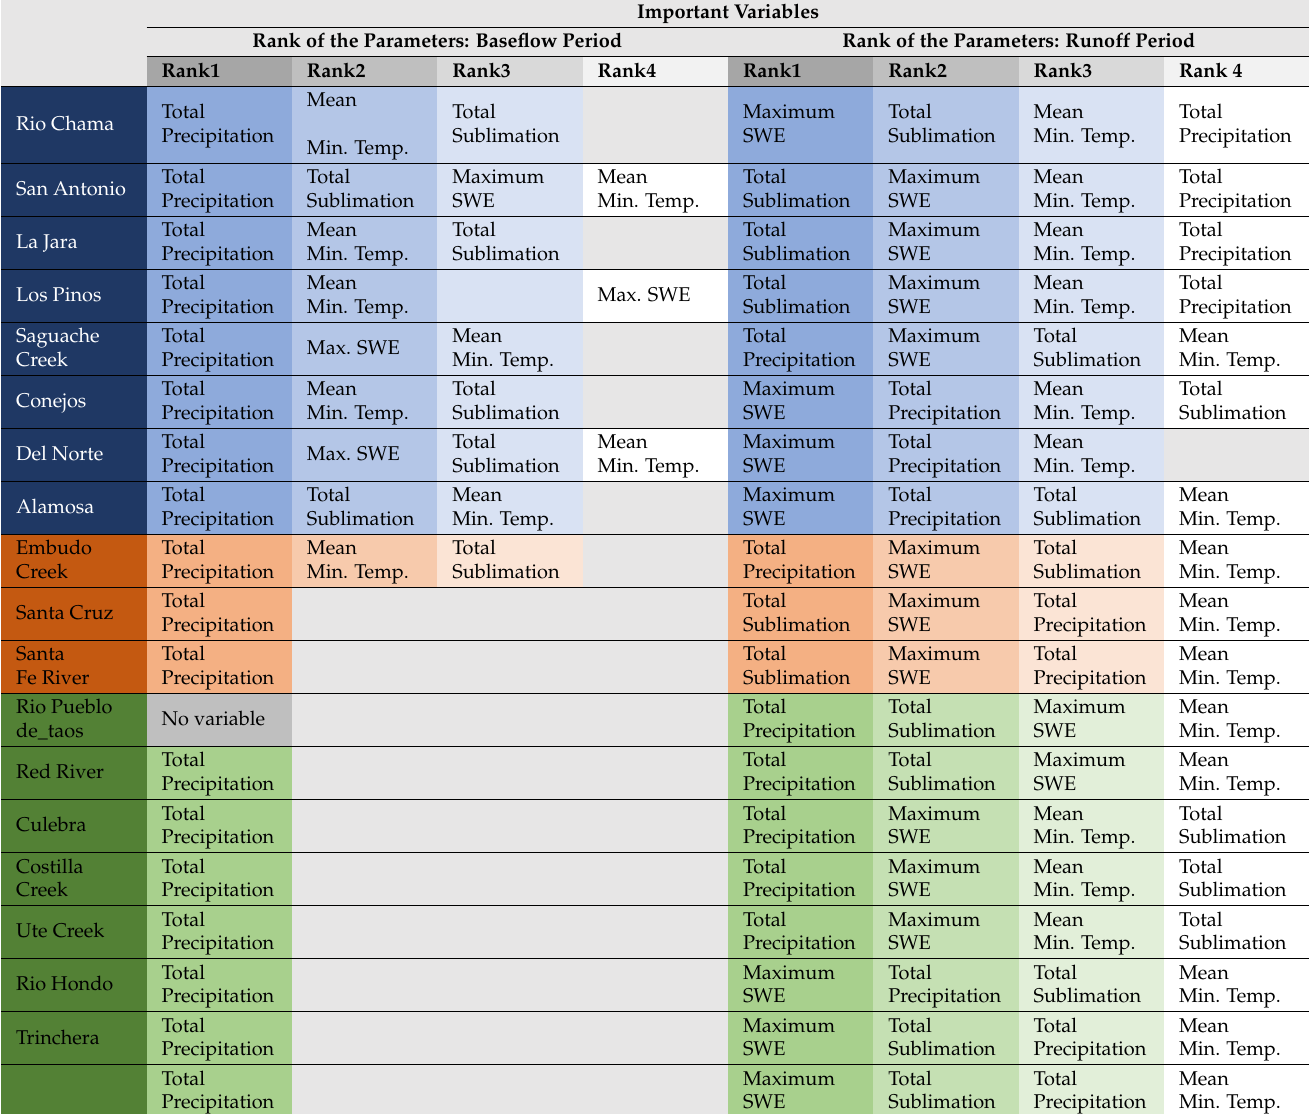
Table 4. Important Parameters along with their ranks for each of the 19